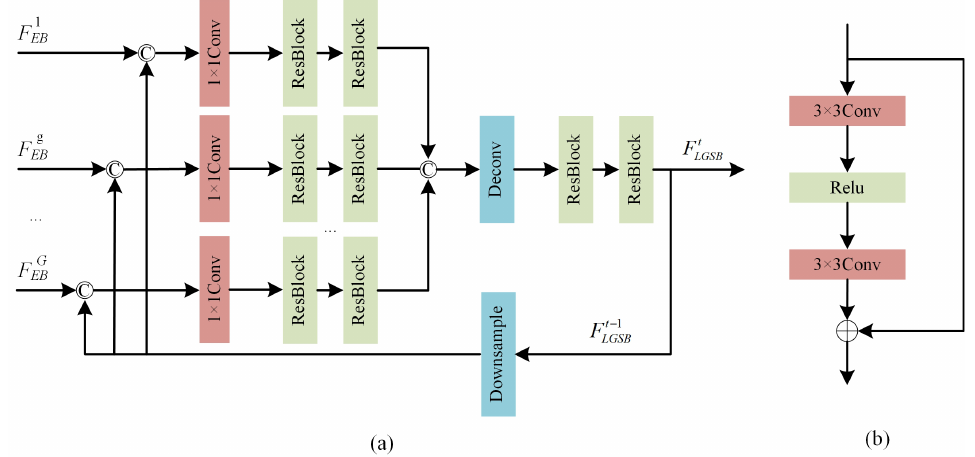
Figure 3. The network architecture of the Local-Global Spectral Block (LGSB): ( a ) the Local-Global Spectral Block, ( b ) the Residual